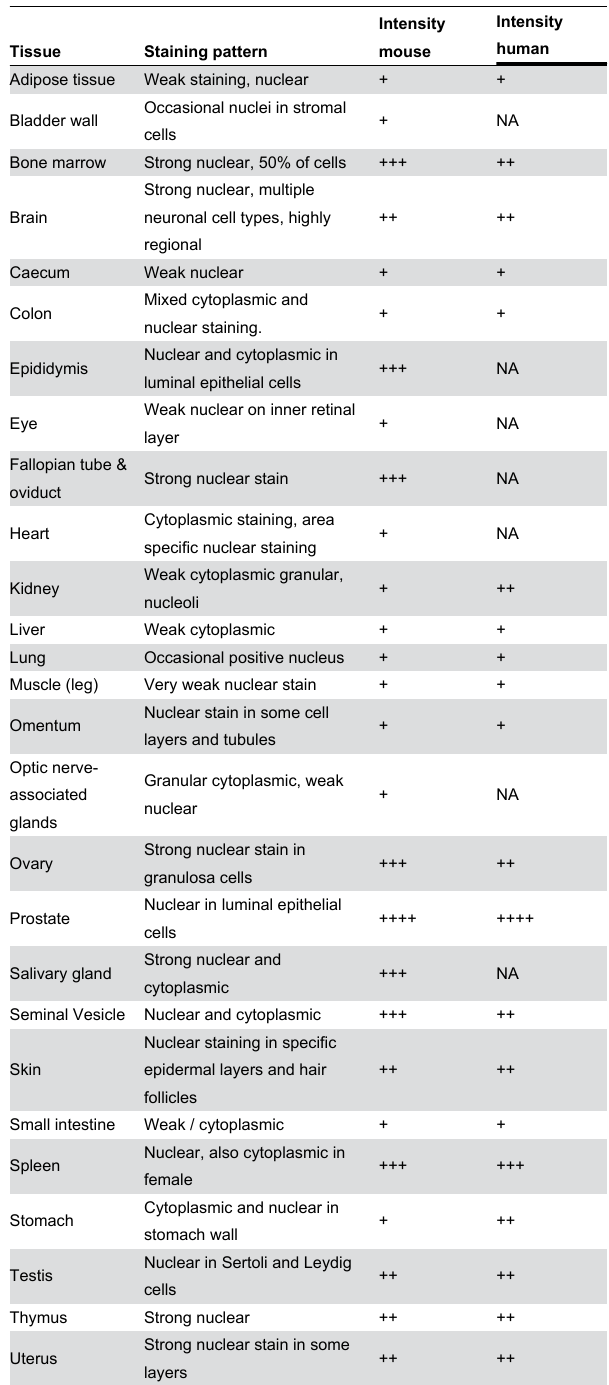
Table 1. Summary of the immunohistochemical analysis of AR in mouse tissue sections, and human normal tissue